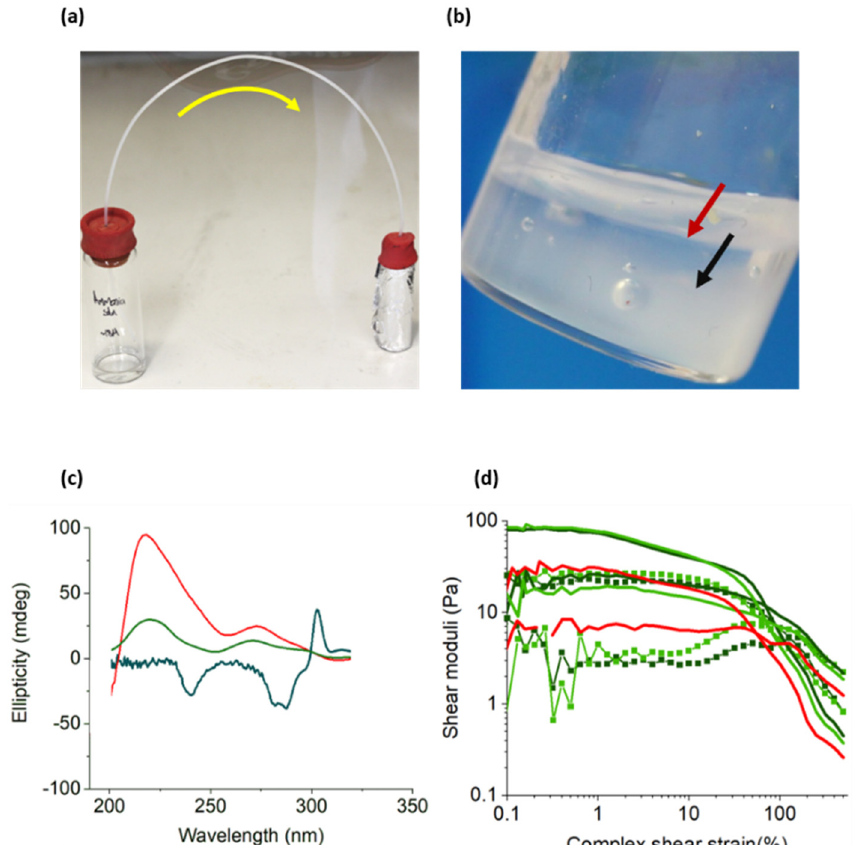
Figure 6. Selective disassembly of multicomponent hydrogels. ( a ) Photo of set up to raise pH whereby ammonia gas flows from the left through the tubing to gradually raise the pH of the supramolecular hydrogel D (the sample is wrapped in tin foil to minimise light exposure. ( b ) Representative photo demonstrating the change in turbidity within the hydrogel D, indicating the gradual disassembly of the supramolecular gel as ammonia diffuses through the sample to raise the pH (Red arrow shows a transparent area of solution and black arrow shows opaque gel). ( c ) CD spectra for gels at elevated pH, 1-1 Ag-GMP (red), A (green), and D (navy). ( d ) Rheology experiments demonstrating a gel retained after raising pH. Thin line plots indicate moduli prior to raising pH and the line and symbol plots post raising pH. For both, ▪ refers to G’ and • refers to G”, the storage modulus and viscous modulus, respectively.